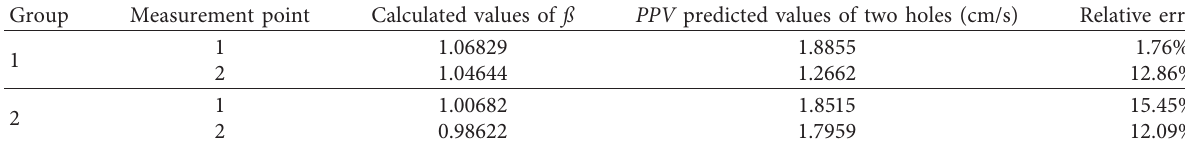
Table 6: Comparison of equation calculation results and field test data results.